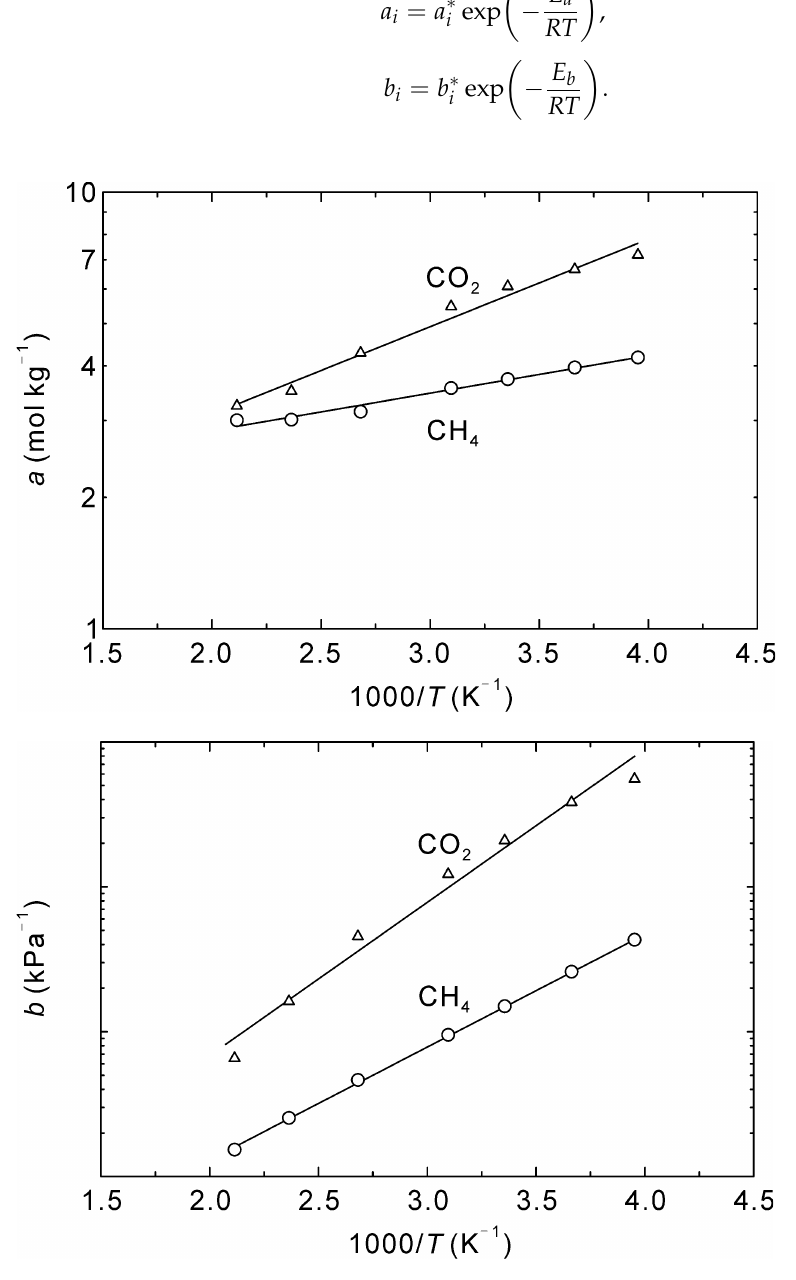
Figure 4. Arrhenius plots of amount of adsorbed at saturation a and Langmuir constant b for CO 2 and CH 4 for the adsorption on CHA-type zeolite with Si/Al = 18.2. The pre-exponential factors and activation energies are listed in Table 2. Assuming the heat of adsorption is equal to − ( E a + E b ), the heats of adsorption for CO 2 and CH 4 are 23.8 kJ mol − 1 and 16.6 kJ mol − 1 , respectively. Maghsoudi et al. experimentally measured the heats of adsorption of CO 2 and CH 4 to be 21.0 kJ mol − 1 and 17.1 kJ mol − 1 , respec-